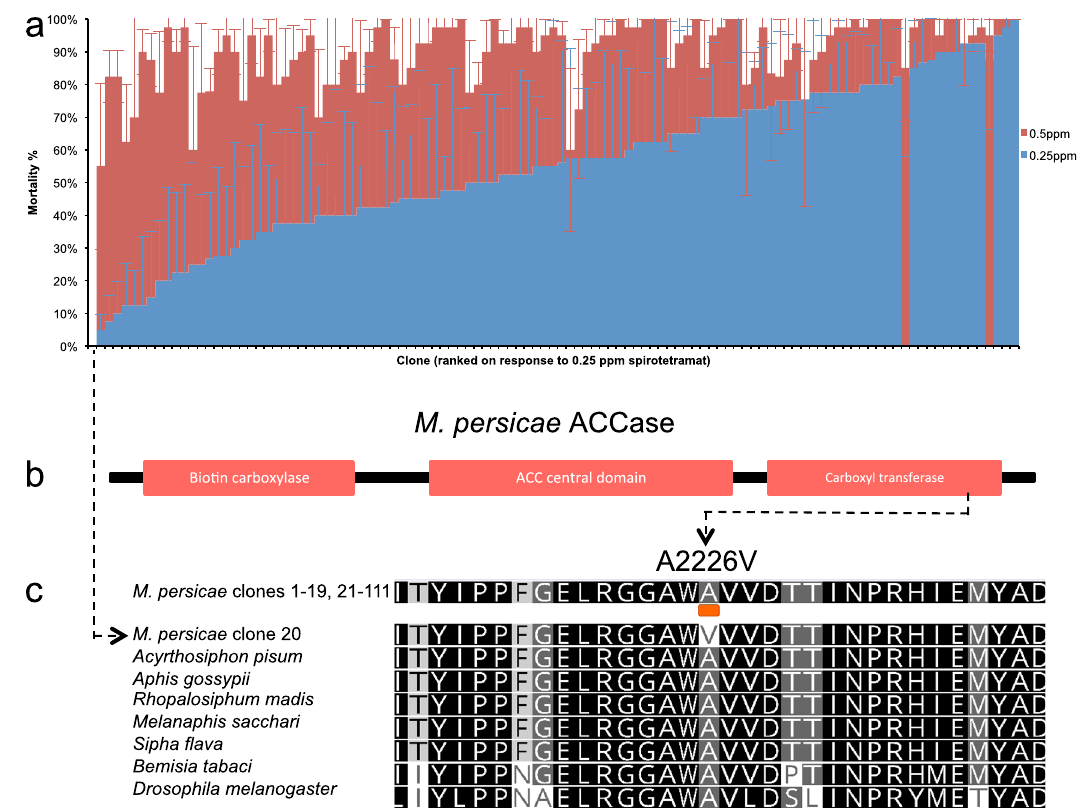
Fig. 6 Population genomics of variation in sensitivity to a recently introduced insecticide. a Sensitivity of 110 clones of M. persicae to two concentrations (0.25 ppm and 0.5 ppm) of the insecticide spirotetramat. Error bars display 95% con fi dence intervals ( n = 4 biological replicates, each comprising 10 aphids). b , c Identi fi cation of a novel resistance mutation in a highly conserved region of the acetyl-CoA carboxylase (ACC) enzyme carboxyltransferase (CT) domain in M. persicae that confers resistance to spirotetratmat. A schematic of the ACC enzyme is shown above an amino acid alignment illustrating the position of an alanine to valine substitution in clone 20 (that exhibits marked resistance to spirotetramat) that was not observed in any of the other M. persicae clones. To illustrate the conserved nature of the alanine at this position across insects the sequences of several other insect species are included in the